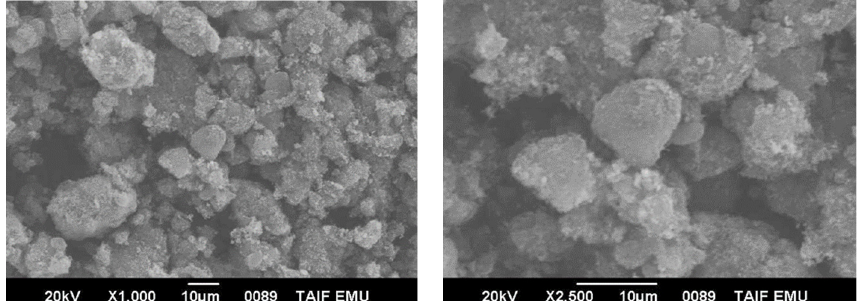
Figure 11. SEM micrographs of the synthesized CrFeO 3 -CNT adsorbent material.